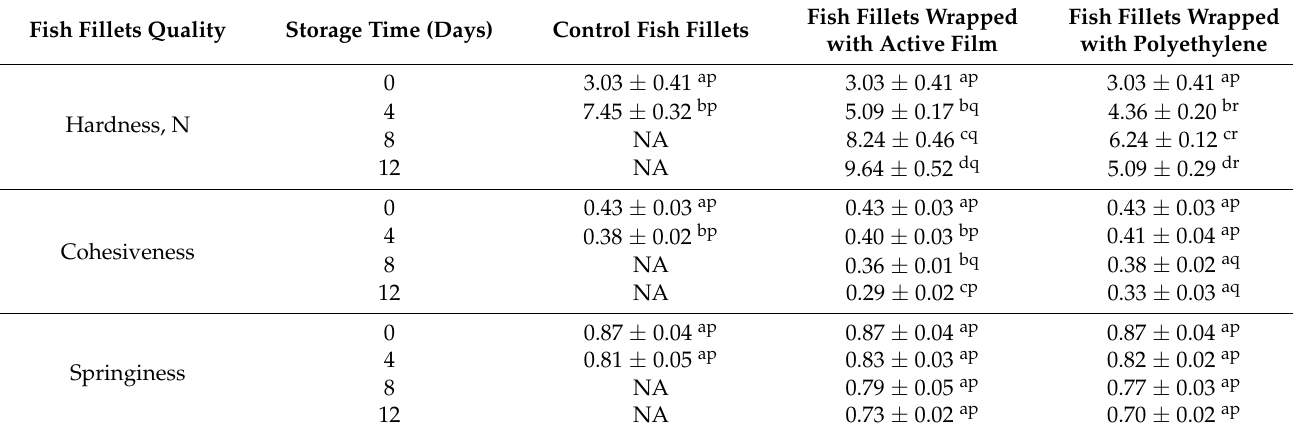
Table 4. Change in texture properties of fish fillets qualities during